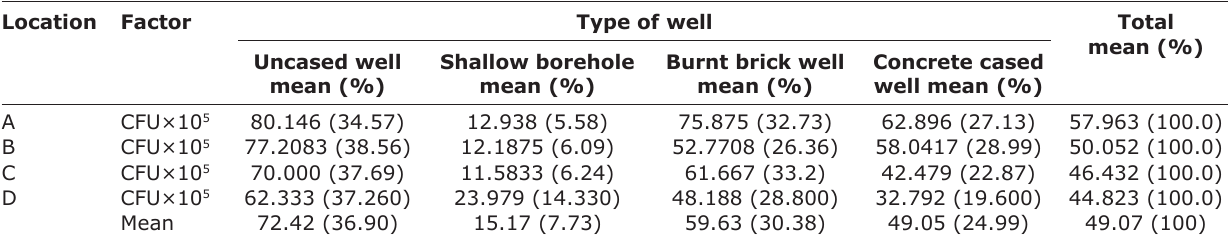
Table-3: Mean colony-forming unit (CFU×10 5 ) in sampled water from wells and boreholes in peri-urban areas of Makurdi (October 2015-September 2016). Location